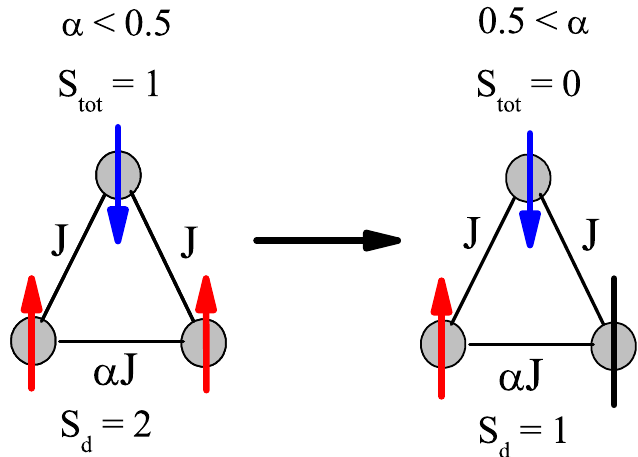
Figure 5. The transition as α is increased through the spin ground state transition. Red arrows indicate spin up states, blue arrows are spin down states, black double headed arrow is the spin neutral